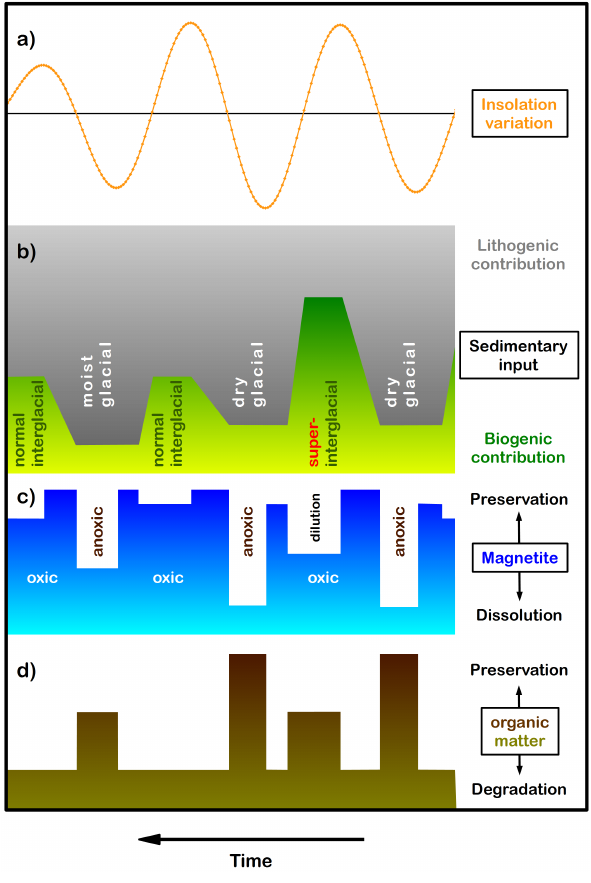
Fig. 5. Simplified sketch of interdependencies of Lake El’gygytgyn sedimentary properties with orbital forcing throughout the Pleis- tocene: (a) variation of summer insolation, (b) lithogenic versus biogenic sedimentary input, (c) magnetic susceptibility, and (d) concentration of organic matter. For detailed explanation see